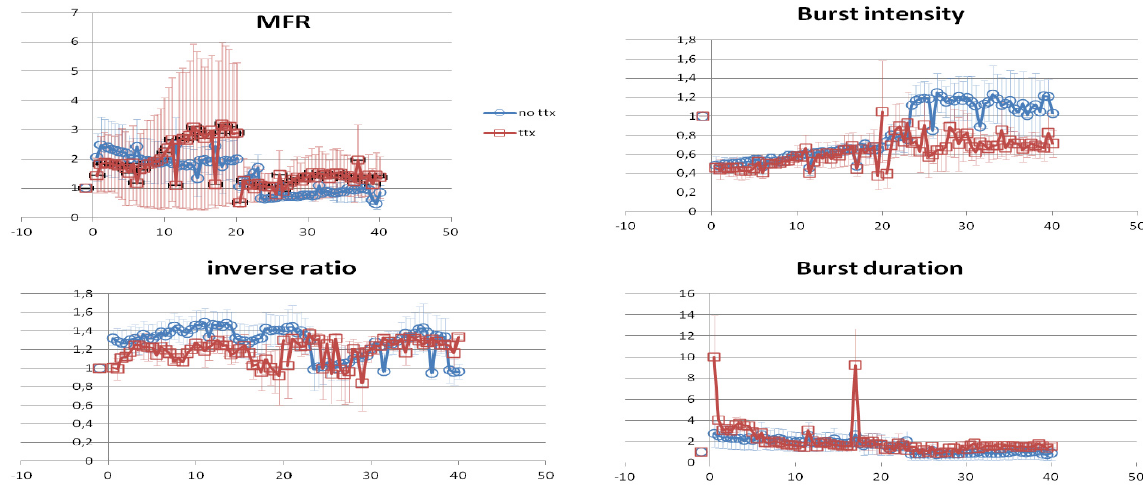
Figure 8. Comparison between control cultures (blue: n = 6) and overnight TTX (20 μ M) pre-treated cultures (red: n = 7) for selected parameters of spontaneous activity. MFR = mean firing rate; burst intensity = intraburst firing rate; inverse ratio = the proportion of spikes falling outside bursts (interspike interval detection criterion for bursts ≤ 100 ms). All values were normalized with respect to the mean level in the 2-h period prior to administering 20 μ M carbachol (for ~20 h), followed by ~20 h of washout. The individual means at each time point were then used to calculate a grand mean for each group, with error bars indicating the SEM. (For examples of actual polyneuronal firing patterns throughout a representative experiment, see [13]).